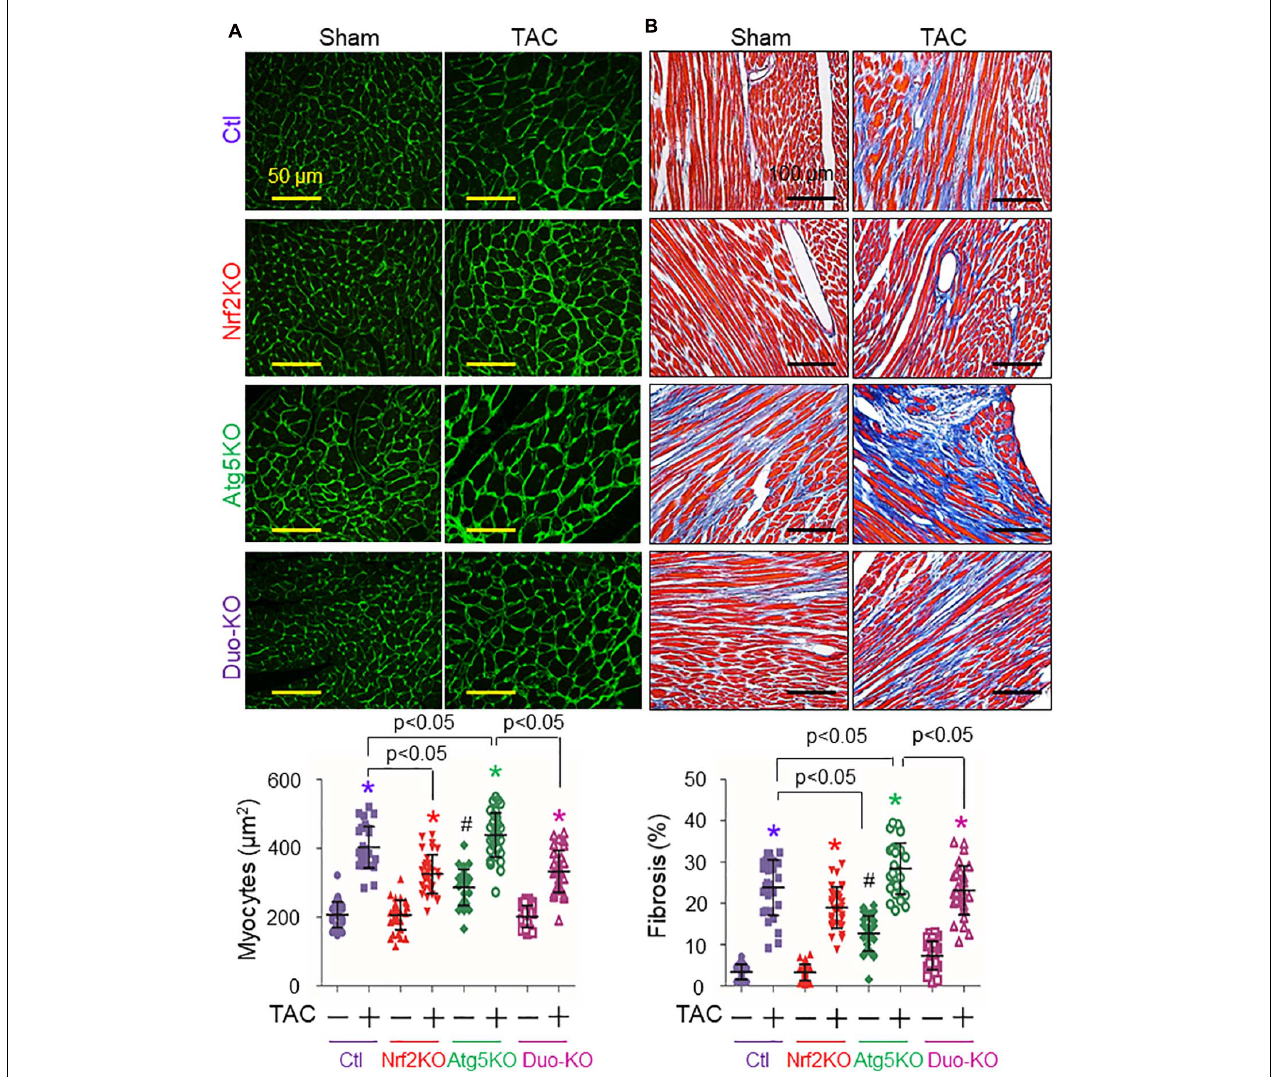
FIGURE 2 | Nrf2-mediated cardiac pathological remodeling in mice in response to pressure overload. The mice with indicated genotypes received tamoxifen treatment as described in the section “Materials and Methods” and then were subject to sham and TAC operation for 6 weeks. (A) Cardiomyocyte sizes. (B) Cardiac fibrosis. Animal number for each group is 3 ∼ 4. * p < 0.05 vs the sham, TAC (–) in the same groups using the Student t test; # p < 0.05 vs TAC (–) in all groups using the Student t test; p < 0.05 between indicated groups using one-way ANOVA followed by Bonferroni